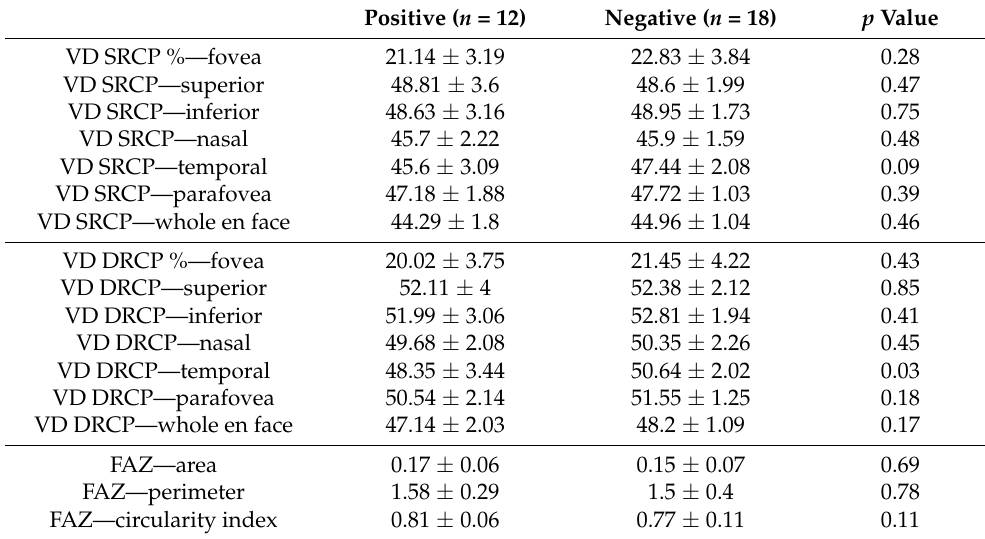
Table 7. Comparison of OCTA parameters among SLE patient using Chloroquine.